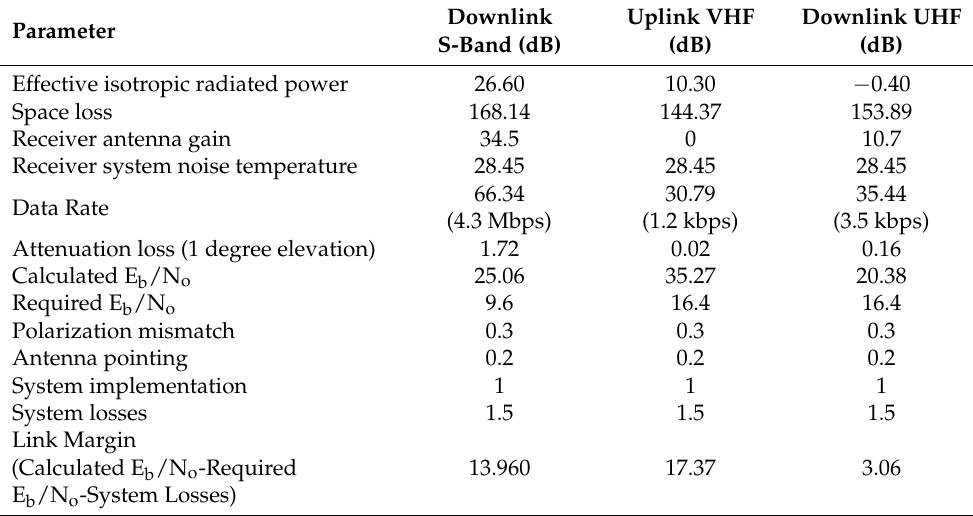
Table 9. RMCSat Communications Link Margin. The margin is determined using the calculated E b /N o less the required E b /N o and System Losses.